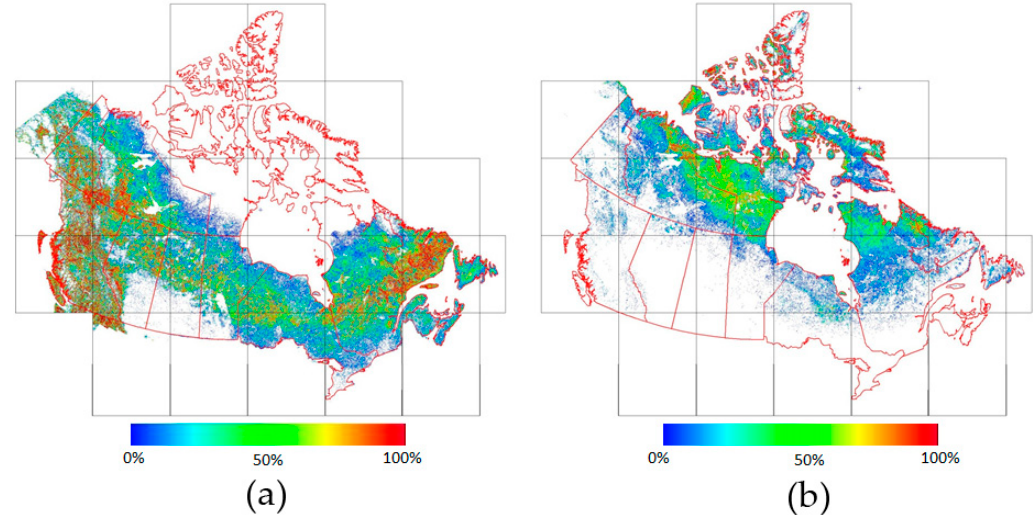
Figure 7. Fractional maps: ( a ) Temperate or sub-polar needleleaf forest; ( b ) Sub-polar or polar grassland–lichen–moss.